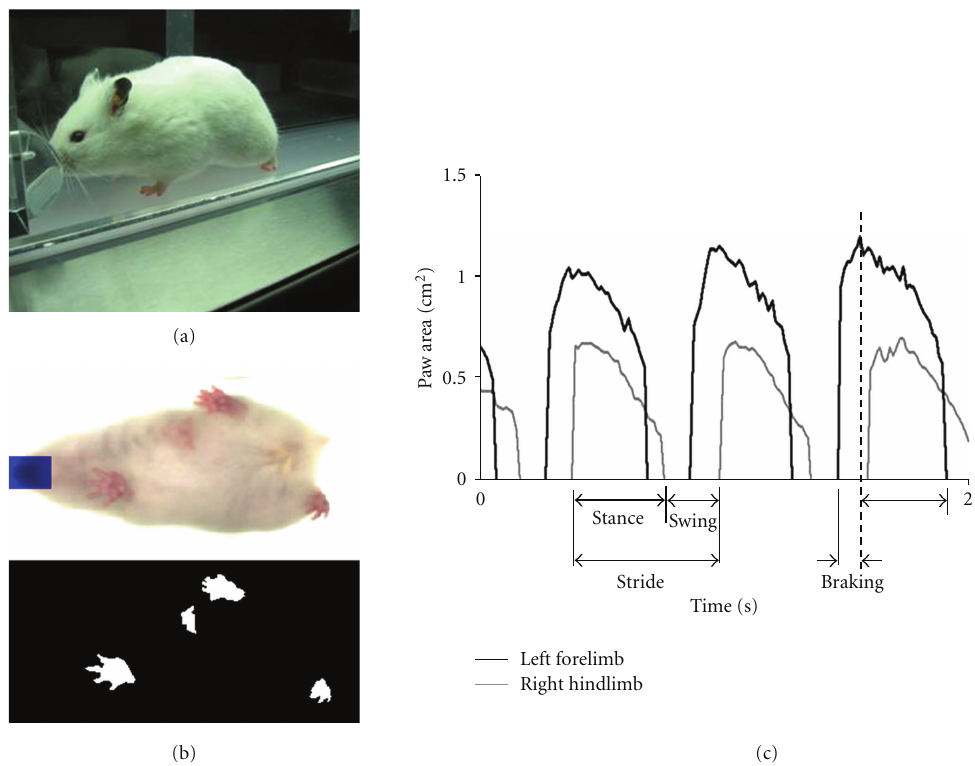
Figure 1: (a) Lateral view of a 9-month-old TO-2 dystrophic hamster walking on DigiGait transparent treadmill belt. The animal walks within an adjustable polycarbonate housing to accommodate a range of animal sizes walking or running at a range of walking speeds (0 to 100cm/s). (b) Individual color image (top) from a digital video recording of the underside of a walking hamster, representing one instance in time. A digital mask was placed over the snout, based on the symmetry and direction of the animal, to prevent the snout from being misinterpreted as a paw. (Bottom) DigiGait software subtracts from each image the pixels that do not match the color of the paws and converts the images to binary, resulting in digital paw prints of the walking hamster. (c) Representative dynamic gait signals of the left forelimb and right hindlimb of a hamster walking at a speed of 16 cm/s. Durations of stance, swing, and stride are indicated for the right hindlimb. Durations of propulsion and braking are indicated for the left